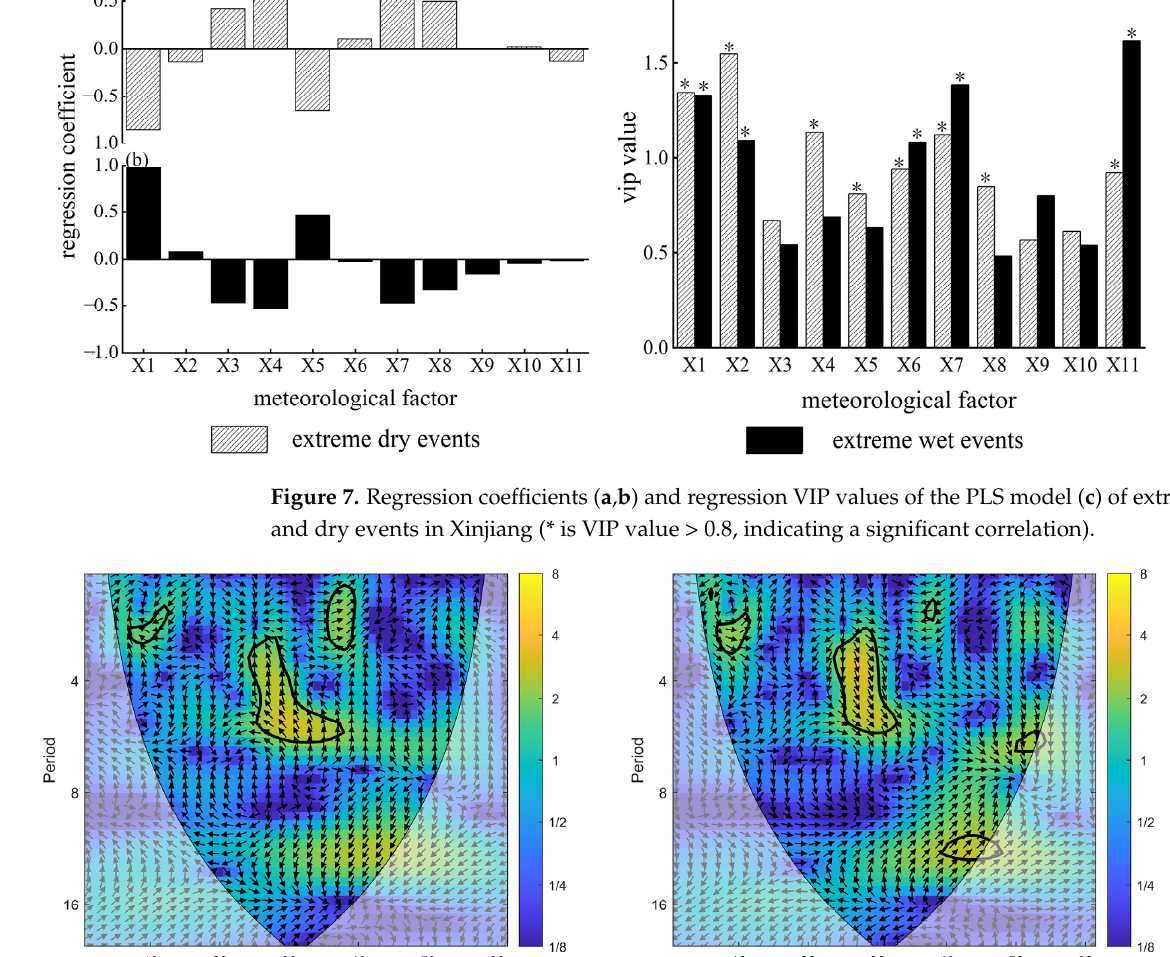
Figure 8. Cross-wavelet transform between extreme dry ( left ) and wet ( right ) events and EI Nino in Xinjiang.